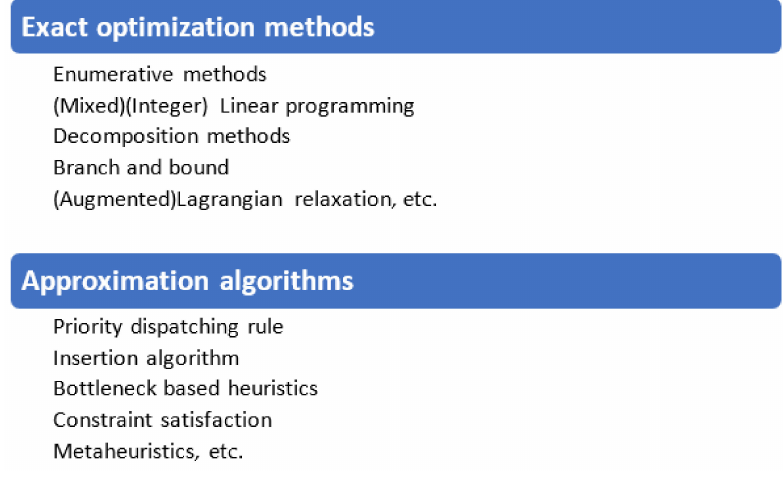
Figure 3. Proposed solution approaches used in scheduling problems.